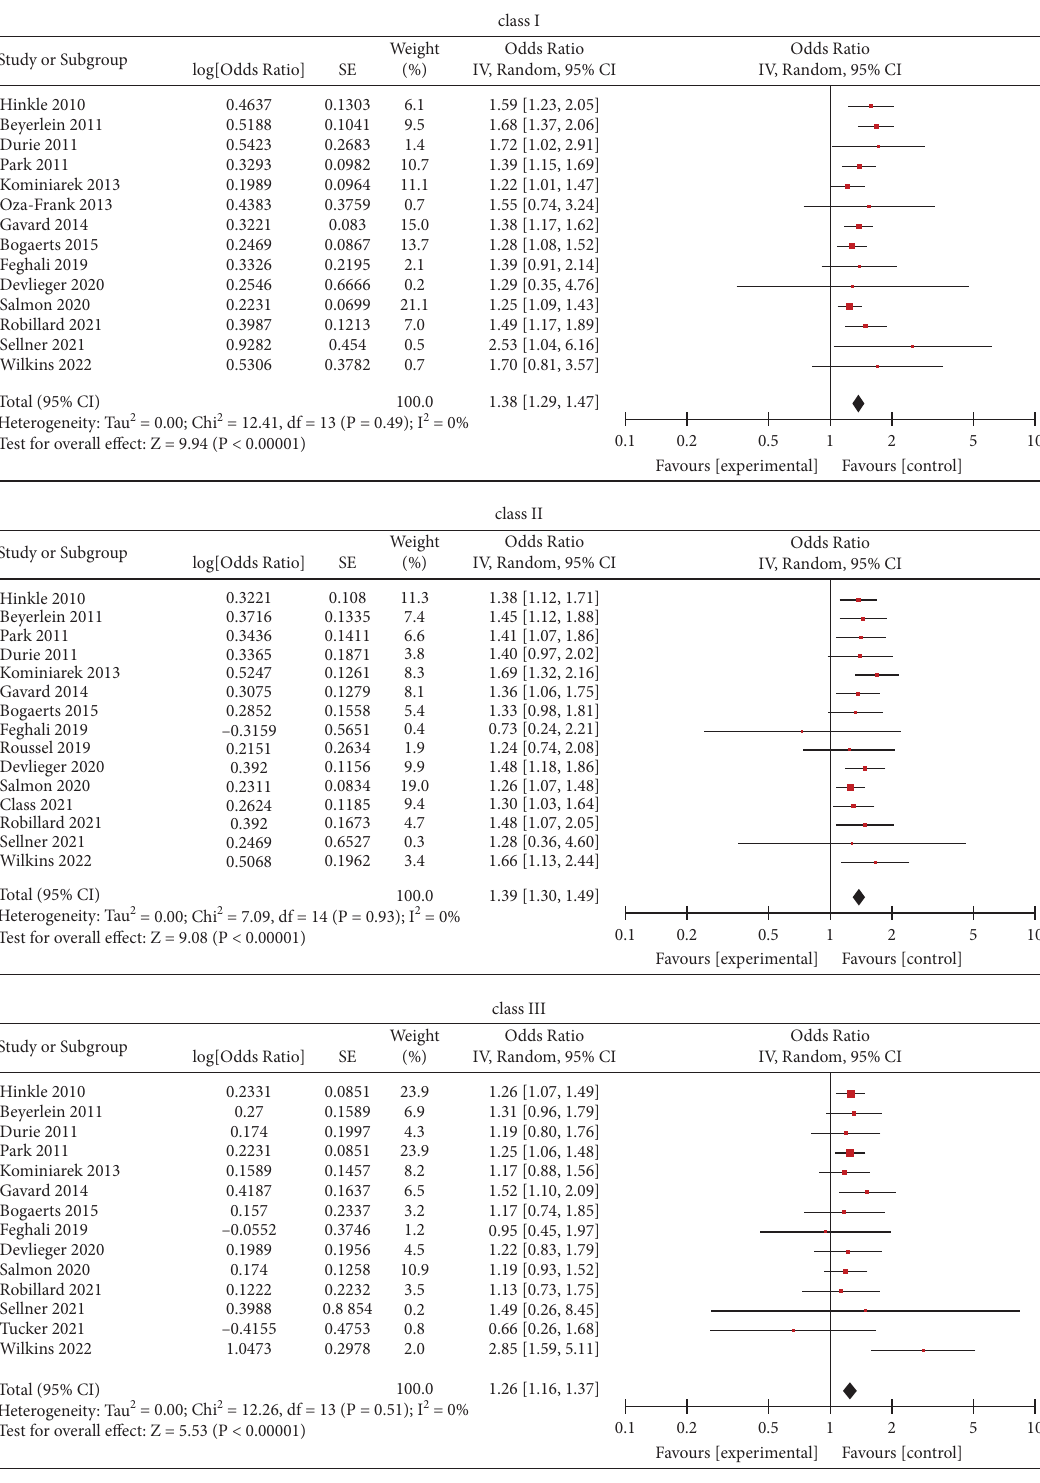
Figure 5: Forest plot of the association between weight gain below the guidelines in obese women of each class group and